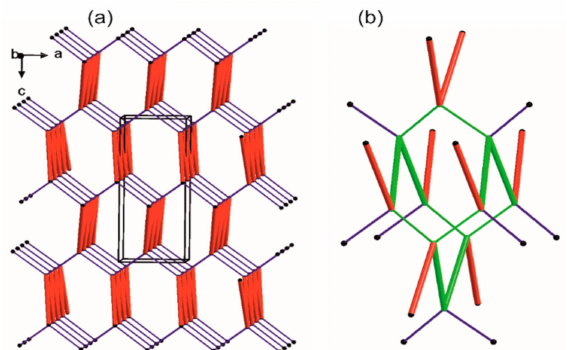
Figure 5. Simplified representation of the crystal packing in 1 . The black balls represent the gravity center of the molecule, red thick vertices are in accordance to a ribbon-like large synthon (motifs a and b jointly) while blue thin lines correspond to N-H ... O hydrogen bonds of motif c . ( a ) Simplified drawing showing the diamondoid 3-D packing; ( b ) A distorted diamondoid fragment of the network (in green). Each node has four connections running along the strongest hydrogen bonds, i.e., two times motif c (blue lines) and two times joint motifs a and b (red lines). In e ff ect, a diamondoid uninodal 4-connected topology is observed with {66} or (6, 4) point group symbols according to Wells or